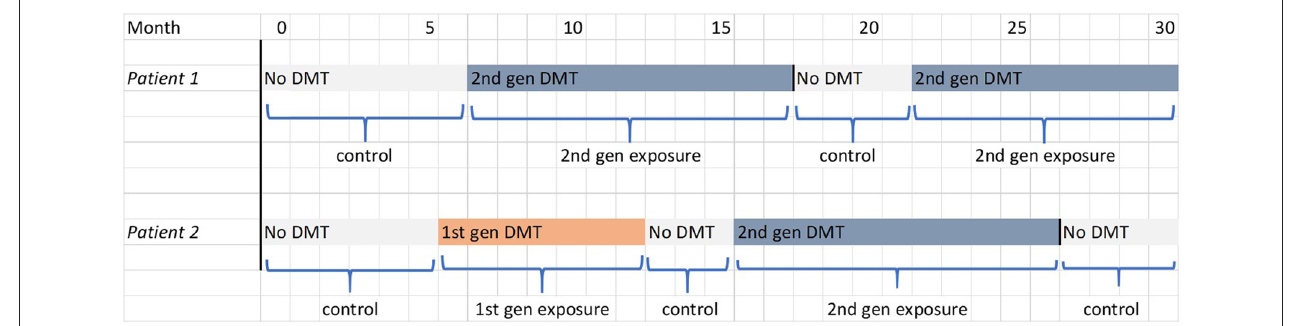
FIGURE 2 | Illustration of the determination of exposure and control periods in the secondary and tertiary cohort analysis for the two hypothetical patients shown in Figure 1 . The filled blocks represent the treatment being received by the patient; the labels below indicate the periods of follow-up that contribute to the